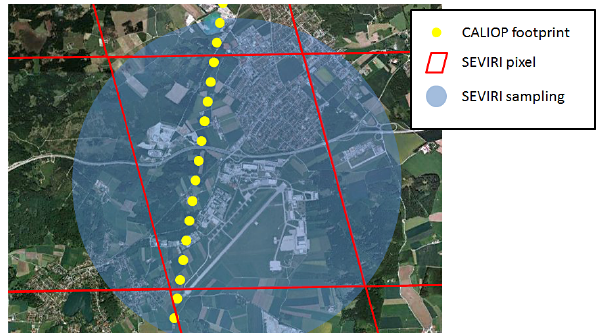
Figure 8. Schematic intercomparison of CALIOP single profile footprints (yellow circles) and SEVIRI pixels (red parallelograms). In blueish colour the sampling area of one SEVIRI pixel is sketched. Note that this is an exemplary plot to represent the different